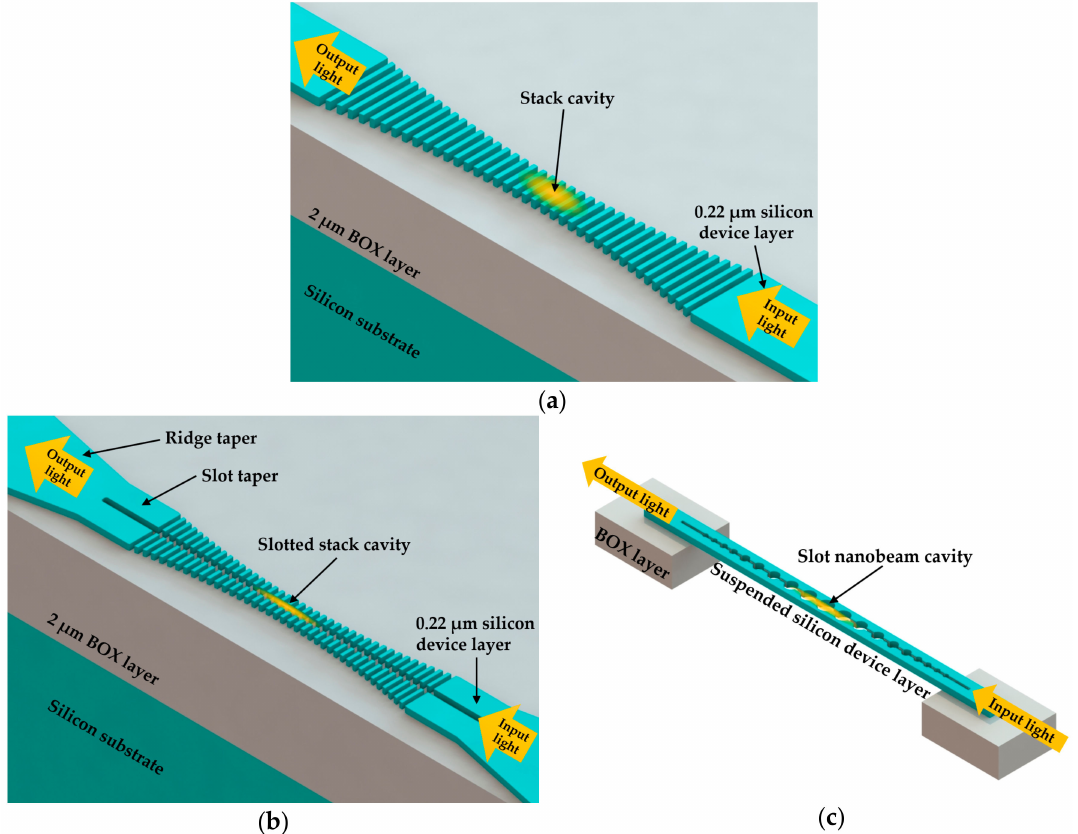
Figure 6. RI sensors aimed at increasing light matter interaction: ( a ) width-modulated stack nanobeam cavity; ( b ) slotted width-modulated stack nanobeam cavity; ( c ) slotted tapered-hole nanobeam